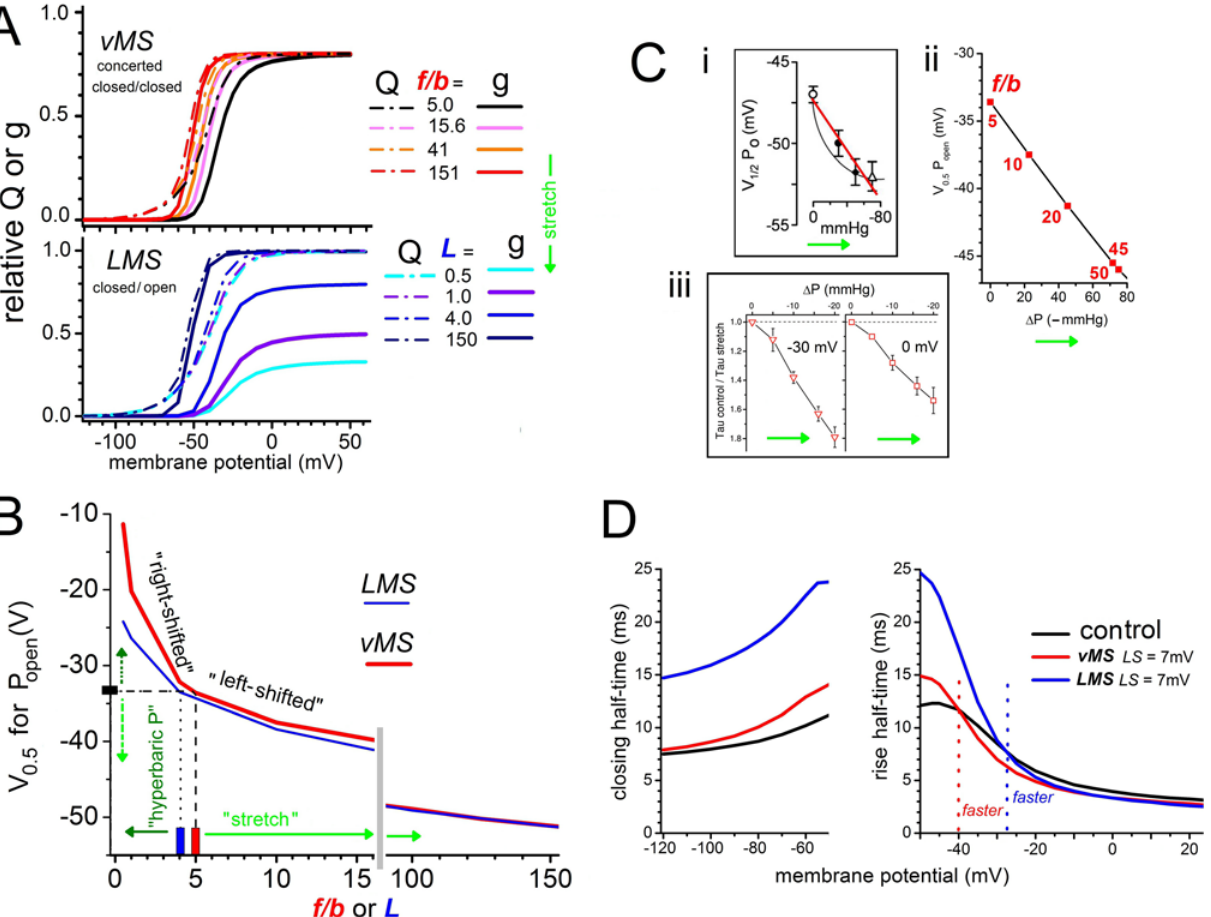
Fig 5. Comparing vMS and LMS using Scheme 3 (concerted pre-opening). A . g(V) s and coinciding Q(V) s (normalized to g(V) s of vMS , where P open-max = 0.8 because L = 4) at the listed equilibrium constant values. For the vMS case, rest tension (no applied stress) is ( f/b) 0 = 5 and for LMS , the rest tension L value would be near 1 as discussed in the text. B . g(V) midpoint ( V 0 . 5 ) as a function of the MS equilibrium constants for each model. Ci . g(V) left-shift data redrawn from Hao et al (2013)[46]. The red line overlay is our “ by-eye ” fit. ii , Scheme 3 vMS- Kv g(V) left-shift calculated as a function of Δ P; P open ( vMS -Kv) was modeled for a hemispherical-section patch whose increasing radius of curvature for 0 to 80 mmHg suction caused membrane-area to increase by 1.4% (the patch model was a perfect hemisphere for a 4% area-increase which is a bilayer ’ s typical lytic limit; other parameter values were K A = 250 mN/m for bilayer stiffness, conformation change Δ area = 3 nm 2; patch radius = 0.5 μ m). LMS left-shift behavior (not shown) is similarly quasi-linear. iii . Replotted data from Fig. 5 of Ref. [56] for MS changes in Nav1.5 fast inactivation kinetics (tight kinetic coupling makes this inactivation process a good proxy for V-